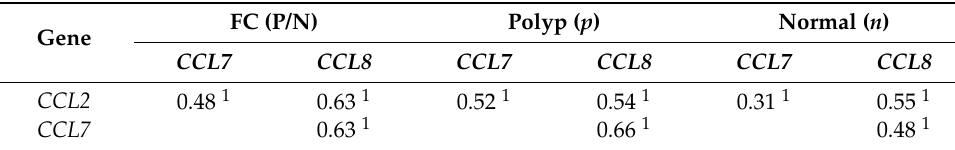
Table 6. Interrelationship between CCL2 , CCL7 , and CCL8